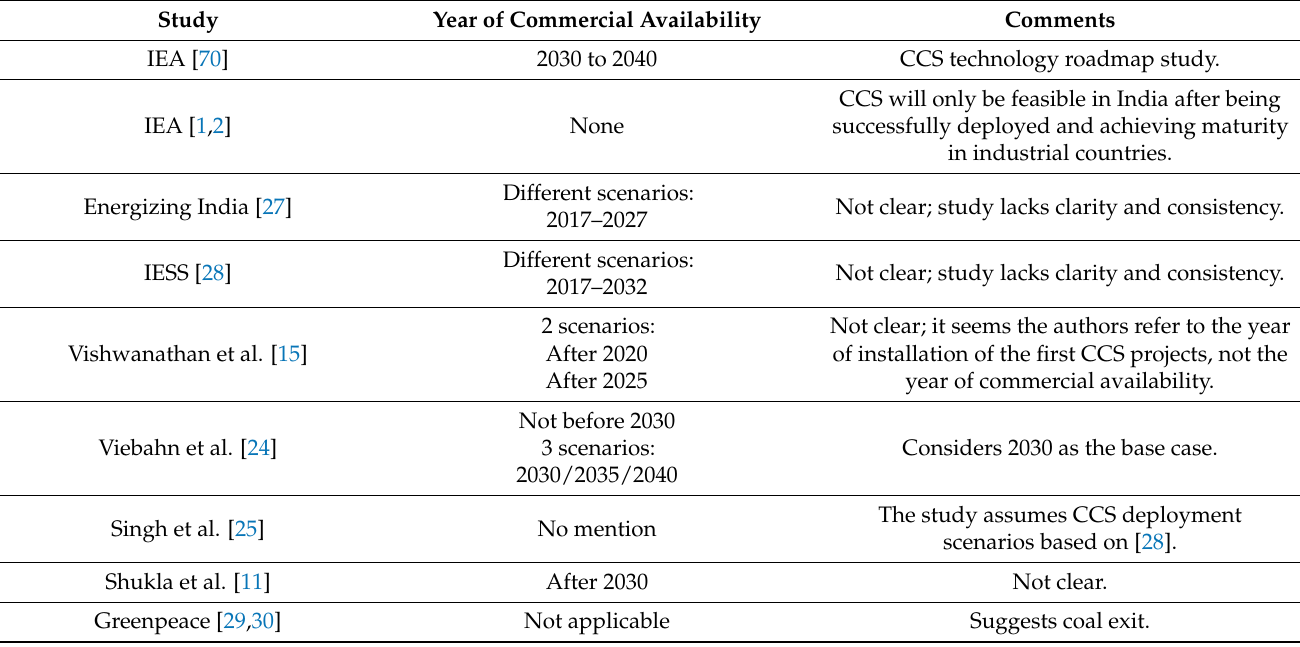
Table 1. Review summary of the expected year of commercial availability of coal-CCS in